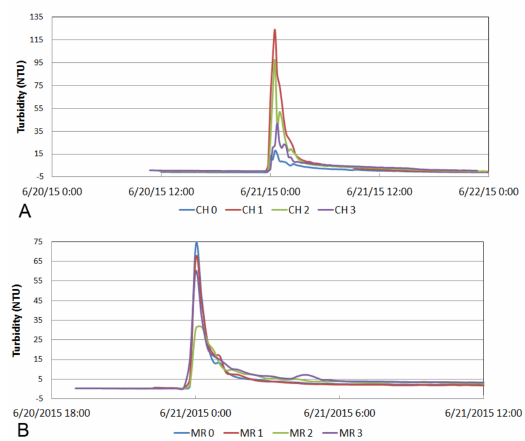
Figure 4. Example turbidity response to storm event. Turbidity response to storm on 21 June 2015 at Chelten Hills ( A ) and Mill Run ( B